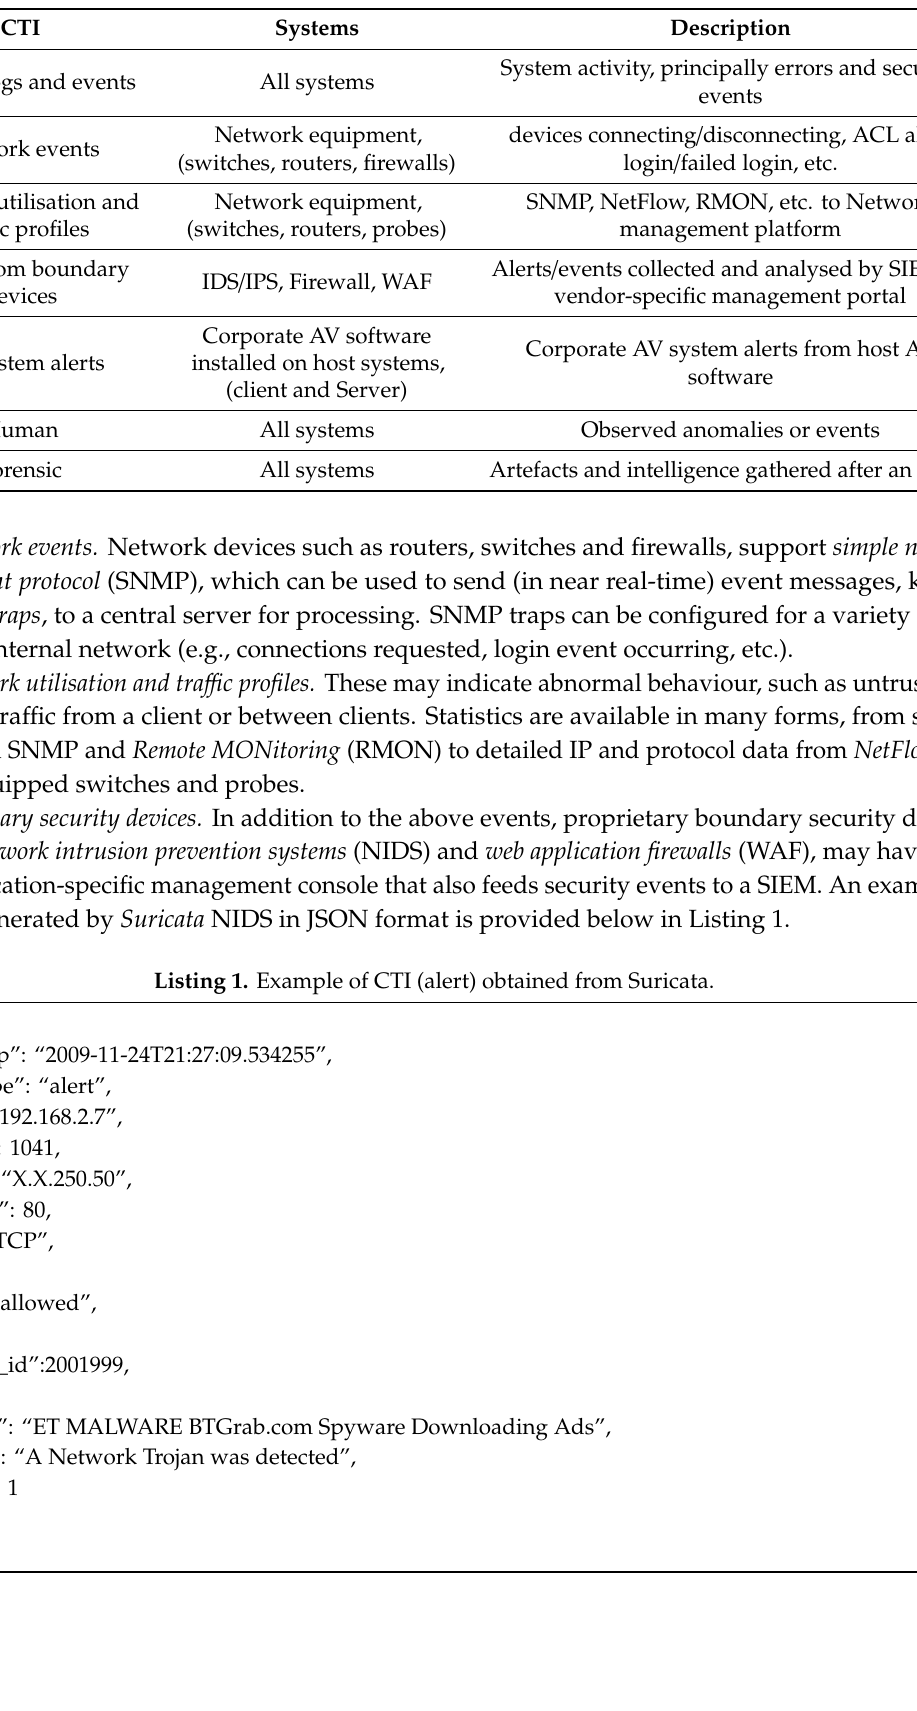
Table 1. Internal sources of cyber-threat